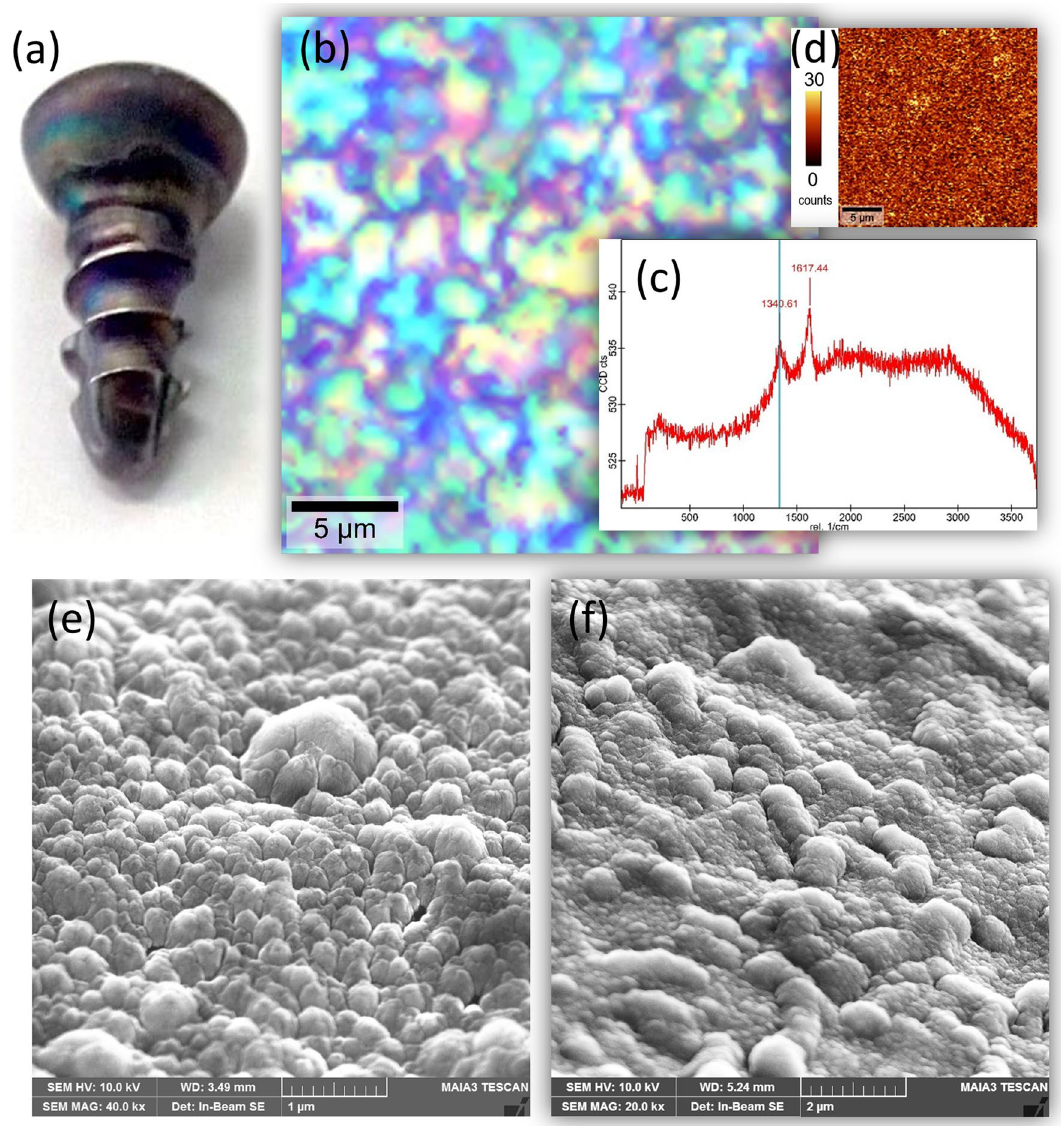
Figure 1. Material and morphological characteristics of the nanocrystalline diamond-coated cortical screws: (a) a photograph of a coated screw, (b) bright-field optical microscope image, (c) Raman spectrum showing characteristic nanocrystalline diamond features, (d) a Raman diamond peak intensity map, (e) SEM image of the coated screw surface along the thread and (f) in the screw tip